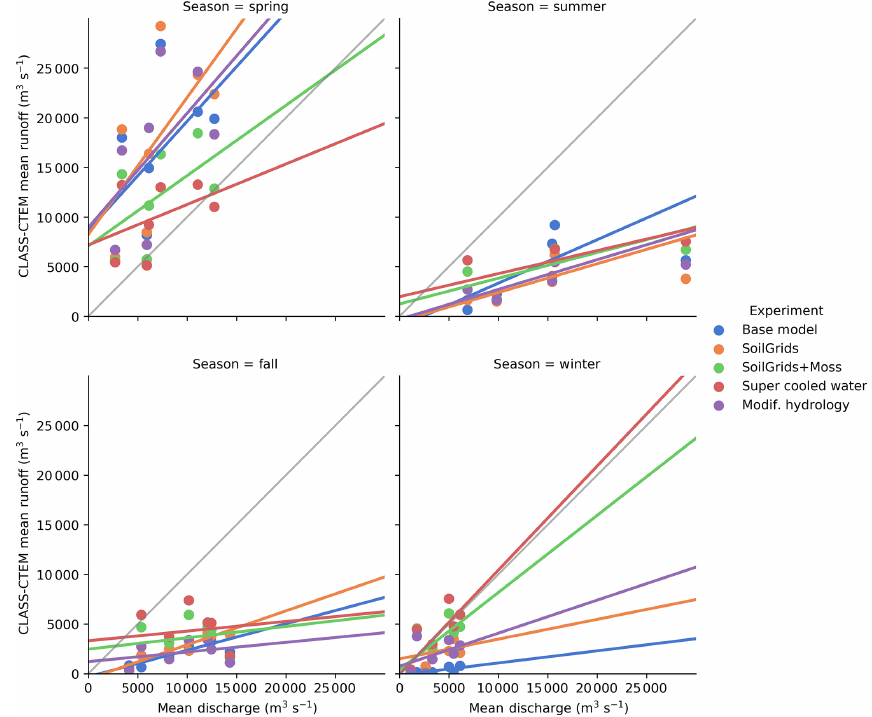
Figure 7. Mean 1965–1984 seasonal discharge of major rivers draining permafrost regions (Ob, Volga, Lena, Yenisei, Yukon, Mackenzie, and Amur; UNESCO Press, 1993) compared to total runoff from selected model runs for the same period. Each dot represents one river basin. The CLASS-CTEM simulated runoff is not routed thus only seasonal values are compared.